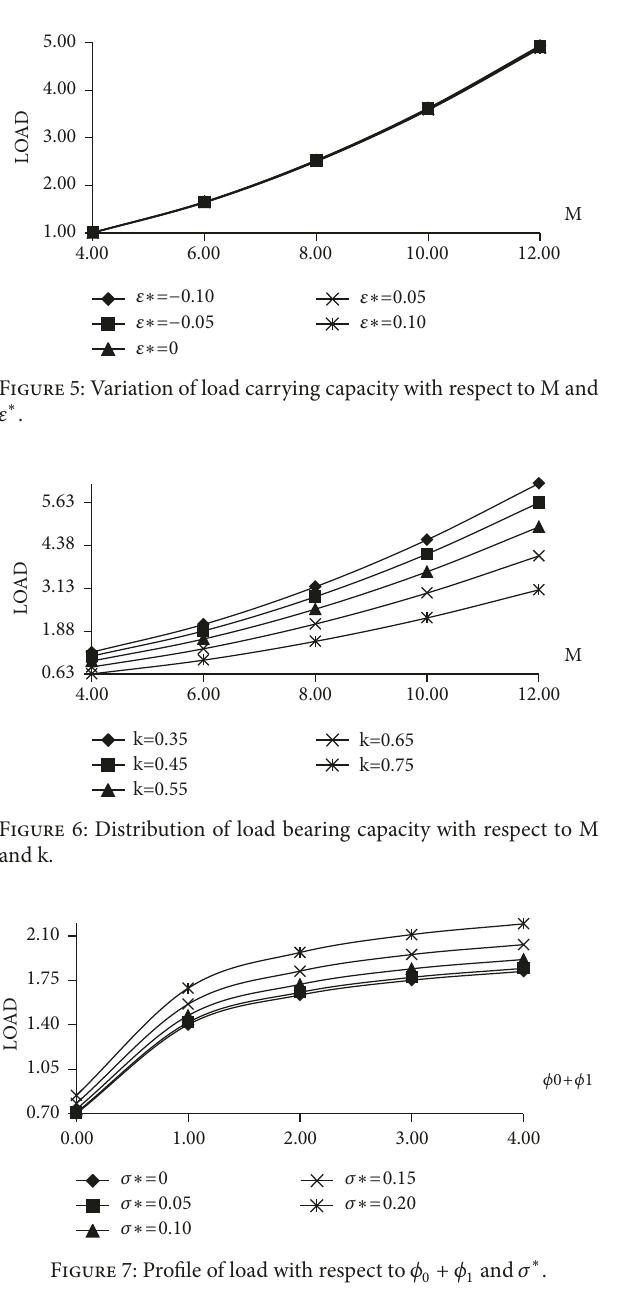
Figure 8: Variation of load carrying capacity with respect to 𝜙 0 +𝜙 1 and 𝛼 ∗ .